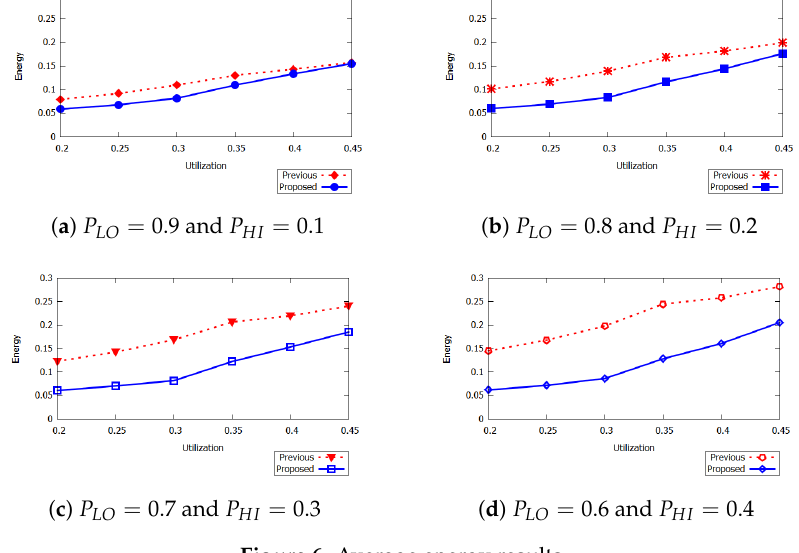
Figure 6. Average energy results.